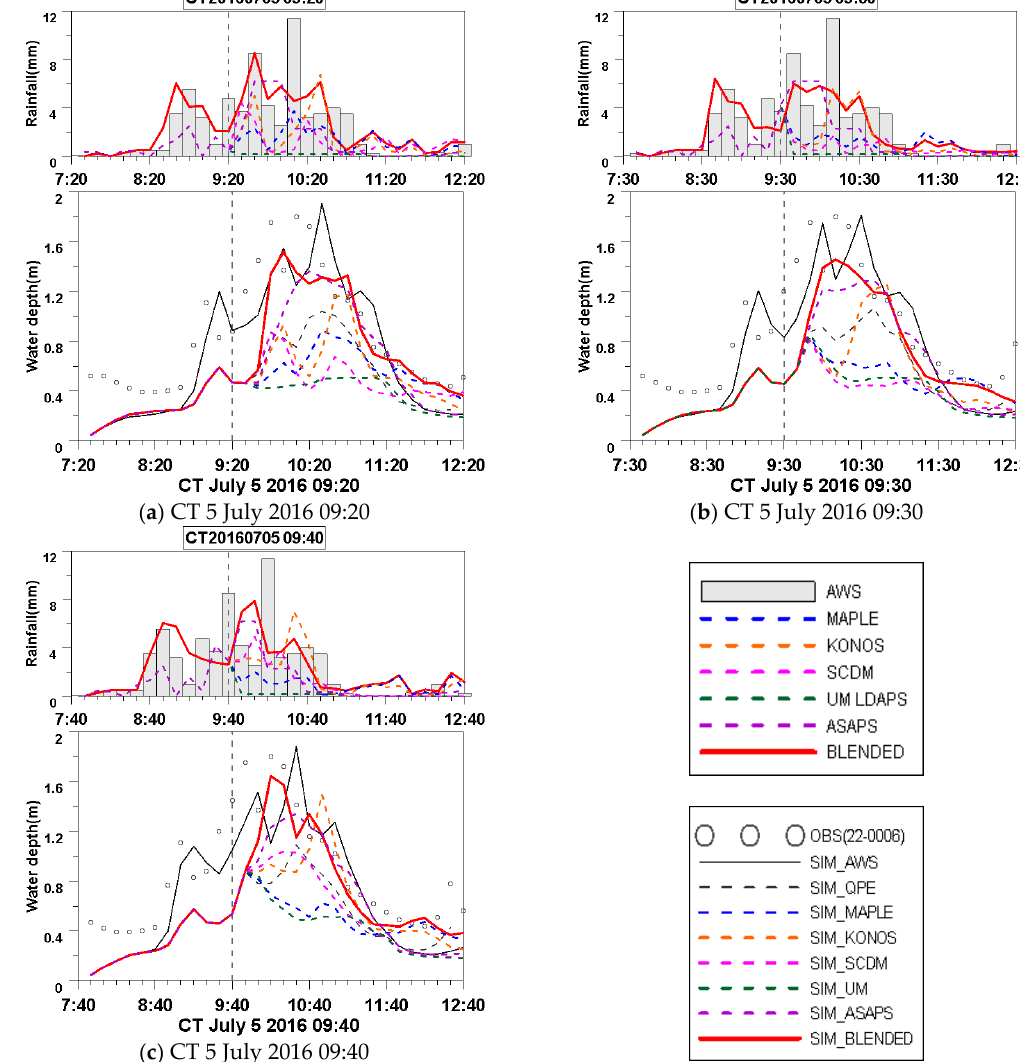
Figure 12. Comparisons between observed and simulated rainfall data using water depth in pipe at three locations in Gangnam for Case 3 (July 5, 2016) over time.